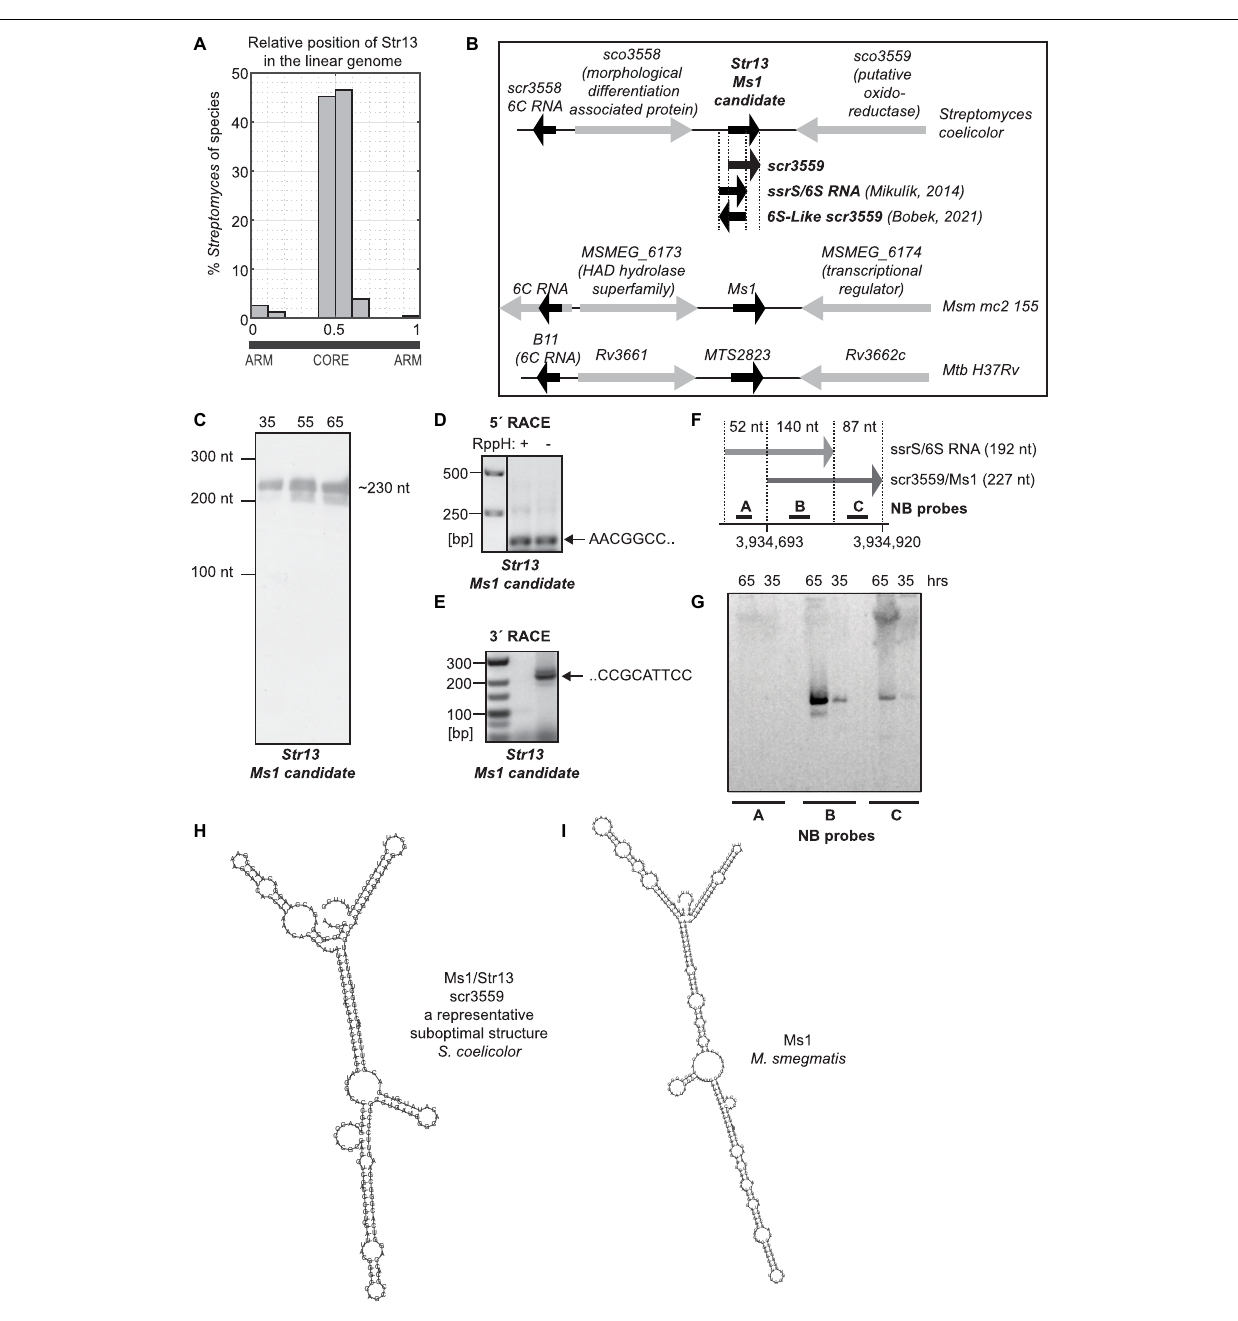
Frontiers in Microbiology |